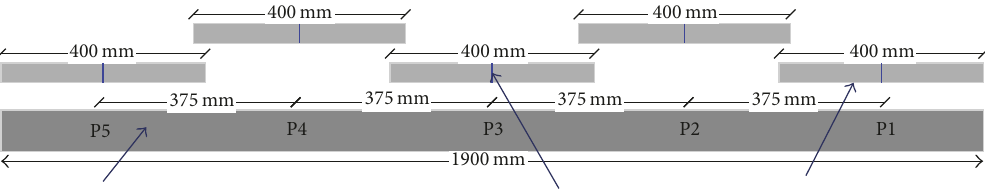
Figure 4: Scheme of platforms positions for regular distribution along the top rail guides course.